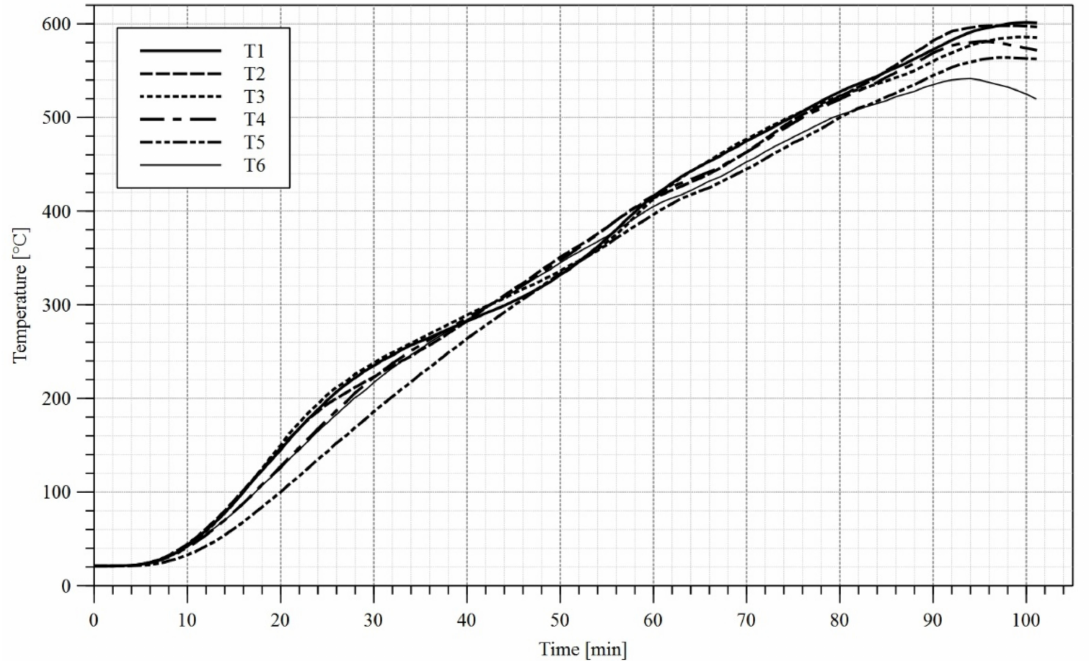
Figure 12. Temperature–time diagram, top and bottom flange, test